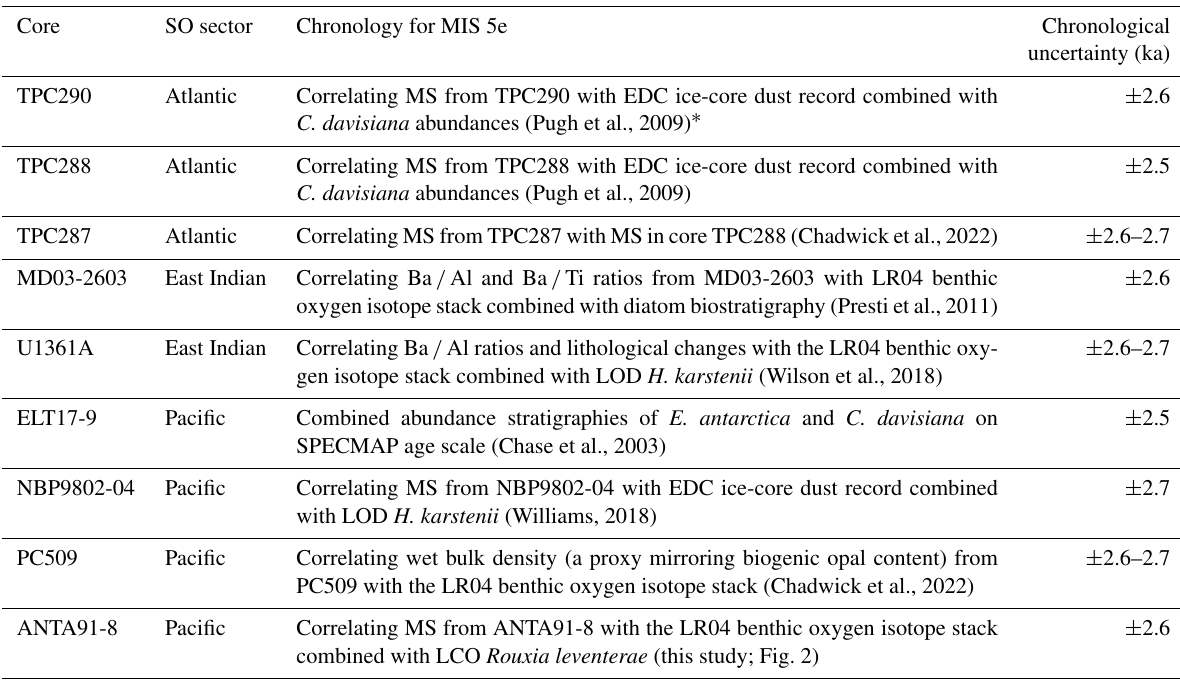
Table 2. Summary of the location and chronologies for the nine sediment cores analysed in this study. Cores are ordered by sector (Atlantic – East Indian – Pacific) and then latitude. LOD: last occurrence datum, LCO: last common occurrence.